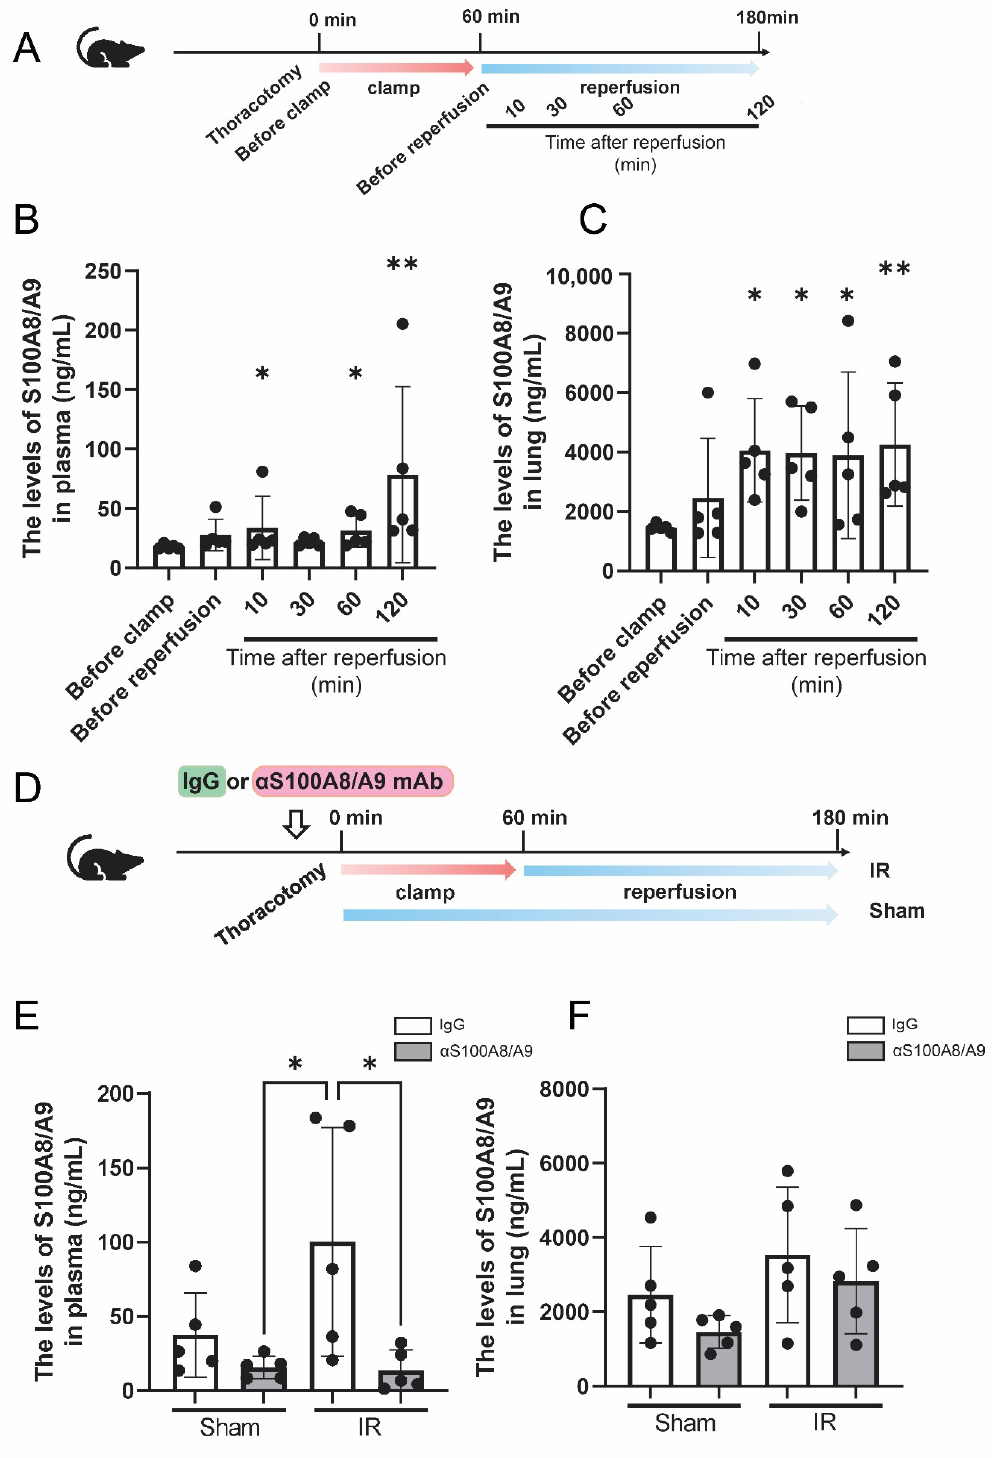
Figure 3. Dynamics of S100A8/A9 in the lung IR model. ( A ) Schematic diagram of time